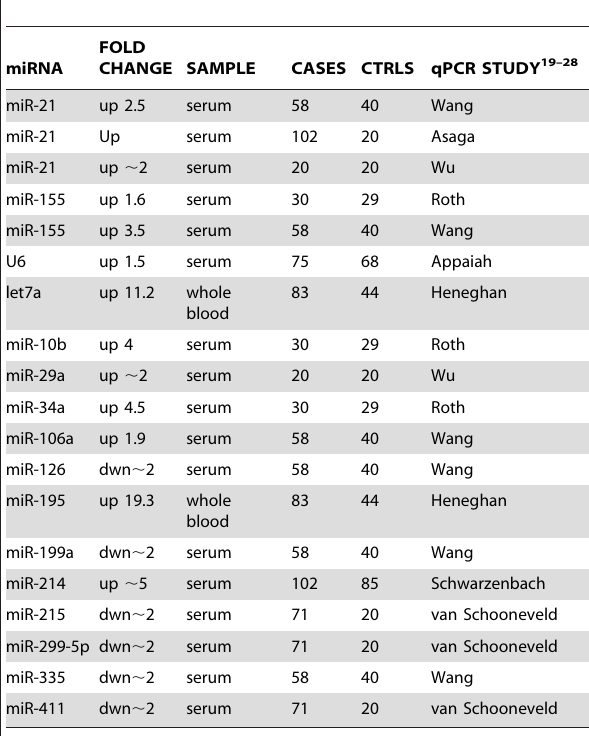
Table 1. qPCR Circulating miRNA Profiling Studies in Breast